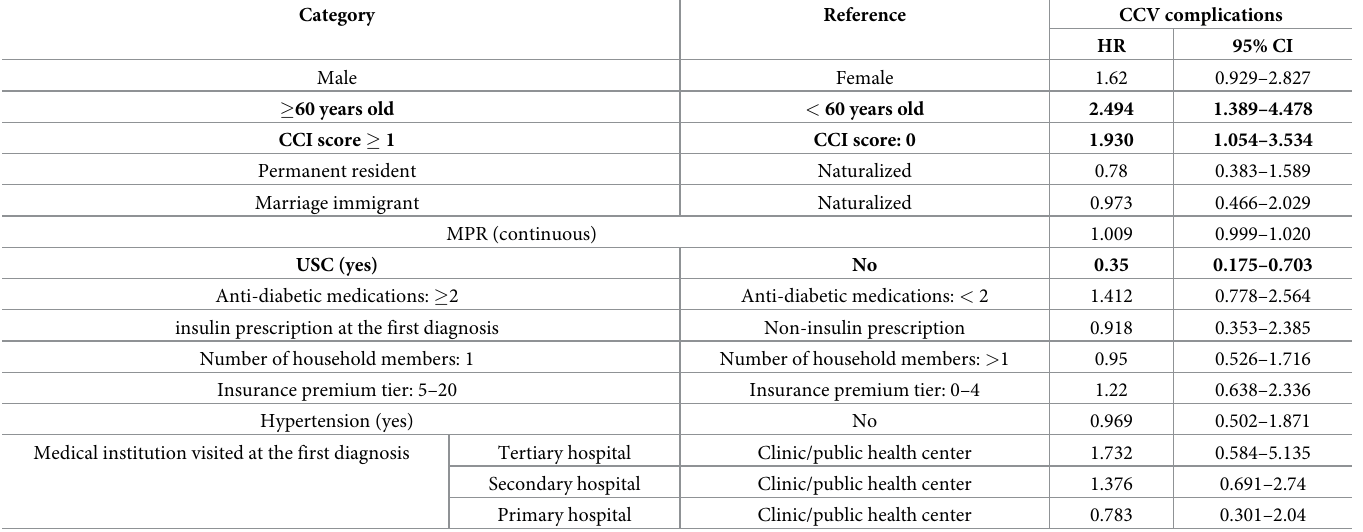
Table 4. Factors that affected the occurrence of cardio-cerebrovascular complications in immigrants.